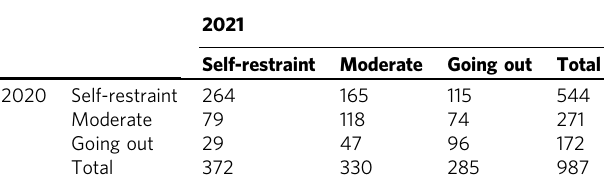
Table 3 Number of people in each